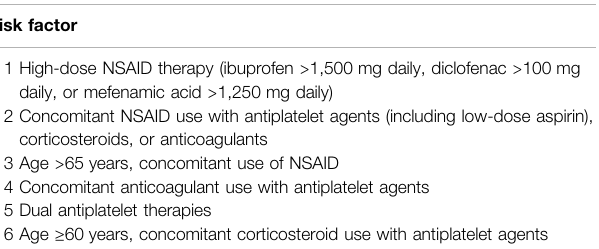
TABLE 2 | Risk factors for drug-related ulcer (García Rodríguez and Jick, 1994; Bhatt et al., 2008; Lanza et al., 2009; Bez et al., 2013). Risk